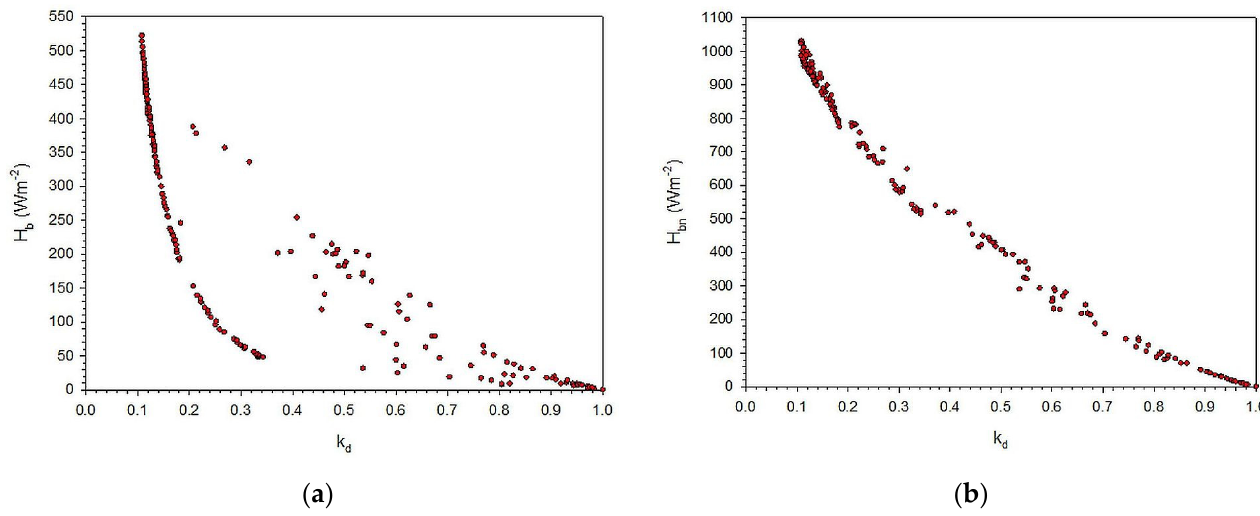
Figure 1. Variation of ( a ) H b and ( b ) H bn as function of k d for January of the PV-GIS TMY-BOU. All data points are hourly values. Dispersion is greater in ( a ).